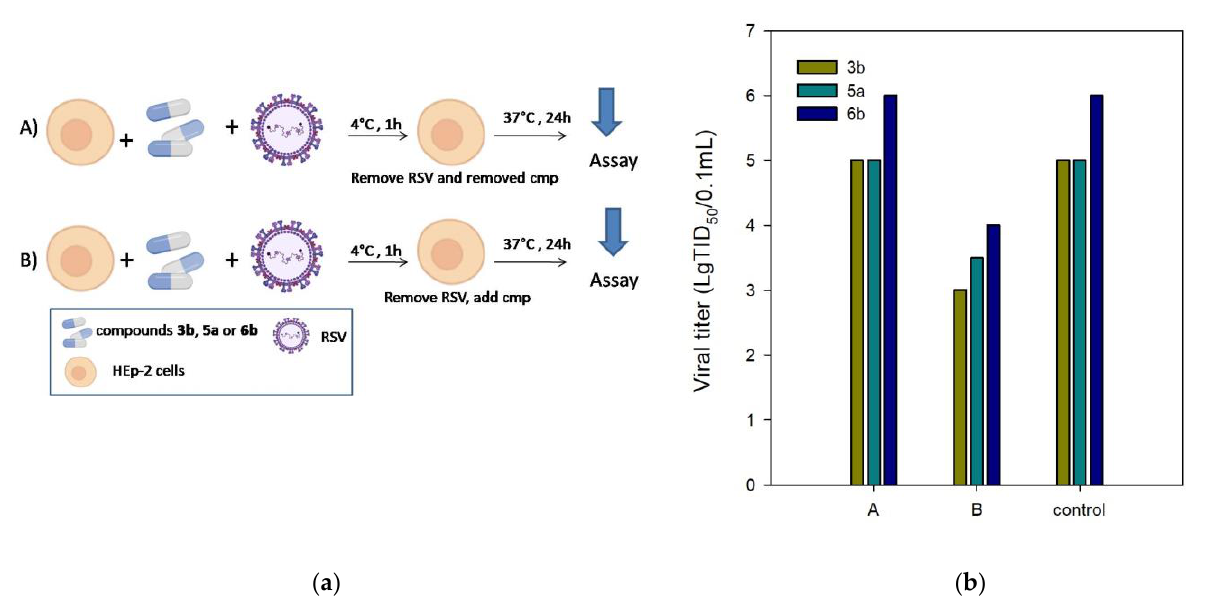
Figure 2. ( a ) HEp-2 cells were incubated with RSV in the presence of compounds 3b , 5a , and 6b at 4 °C for 1 h and then washed to remove unbound virus and inhibitor (A), or washed to remove unbound virus and compounds added before the temperature was shifted to 37 °C (B). ( b ) Inhibition of RSV infection by the test compounds under experimental conditions (A) and (B).